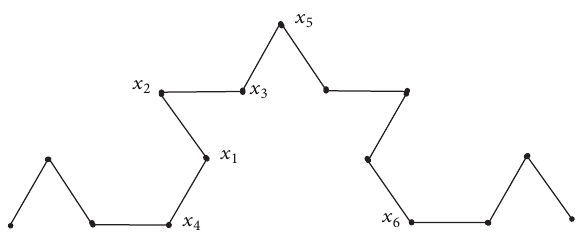
Figure 2: Koch’s curve, which is similar to the generation of Cantor ternary set (see Figure 1), is defined by repeatedly adding the middle thirds of line segments